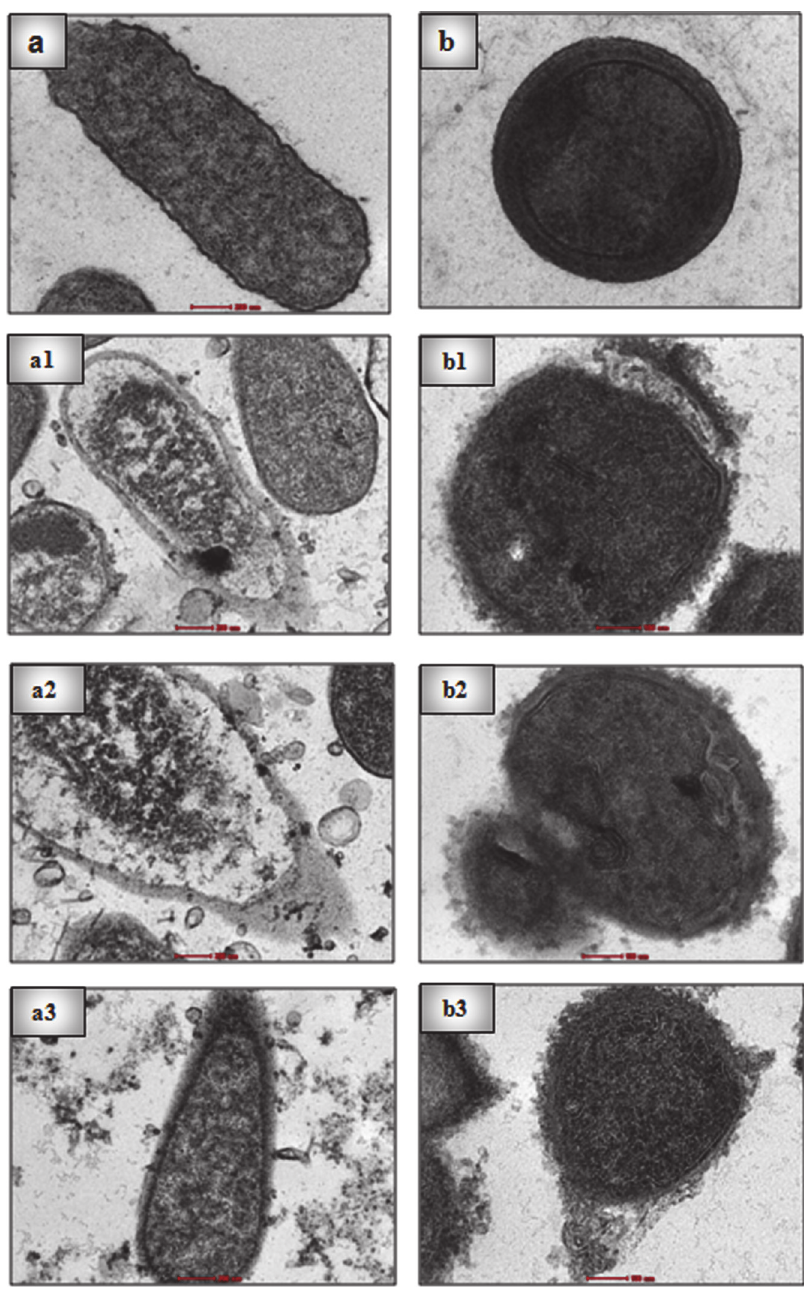
Fig 8. TEM images of bacteria. Figure showing morphology of bacteria. (a) untreated E . coli (b) untreated S . aureus . (a1-a3) show E . coli and (b1-b3) show S . aureus treated with CSNP3, CSNP4,